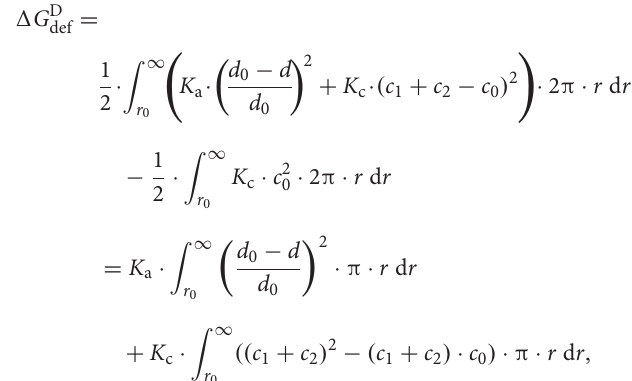
FIGURE 2 | Gramicidin channels as molecular force probes. Gramicidin channels form by transmembrane association of b 6 · 3 -helical monomers imbedded in each monolayer, which is associated with compression and bending of the two bilayer leaflets toward each other. The local bilayer deformation imposed by the hydrophobic mismatch between the channel and its host bilayer, produces a compression of (each leaflet of) the bilayer with an energy density 1 / 2 · K a · (( d 0 − d )/ d 0 ) 2 , where K a denotes the elastic area-compression modulus, d 0 the thickness of the unperturbed bilayer, and d the local bilayer thickness as function of distance from the channel, and a bending of the each monolayer/solution interface with an energy density we approximate as 1 / 2 · K c · ( c 1 + c 2 − c 0 ) 2 where c 1 and c 2 denote the principal components of the local curvature. Bottom: Single channel current transitions associated with channel formation/dissociation (0: no channel; 1: conducting